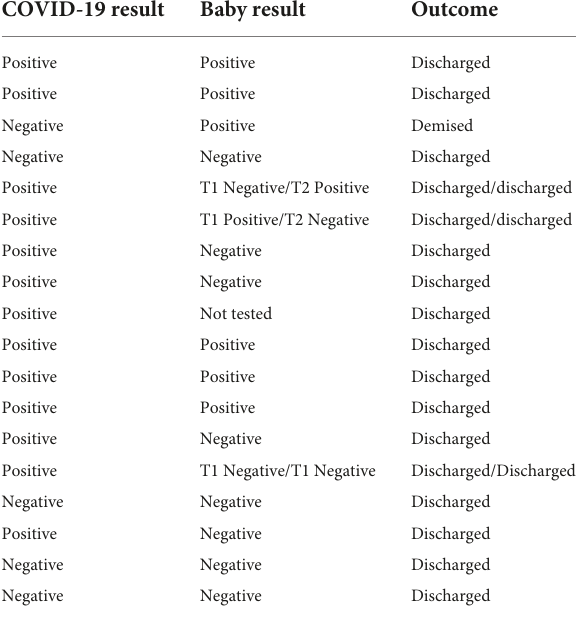
TABLE 1 Results of COVID test and outcome of the mothers and neonates in the kangaroo mother care (KMC) ward. COVID-19